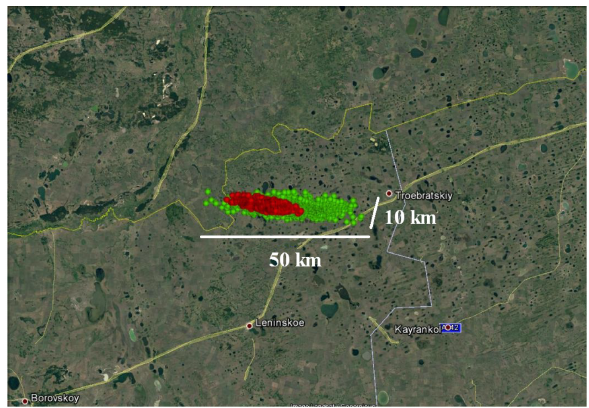
Figure 7. Entry points region for Chelyabinsk meteoroid being ob- served with SODA system in two SC option. Green points corre- spond to length of arc 8 hours in variant 3, red ones for 15 hours in variant